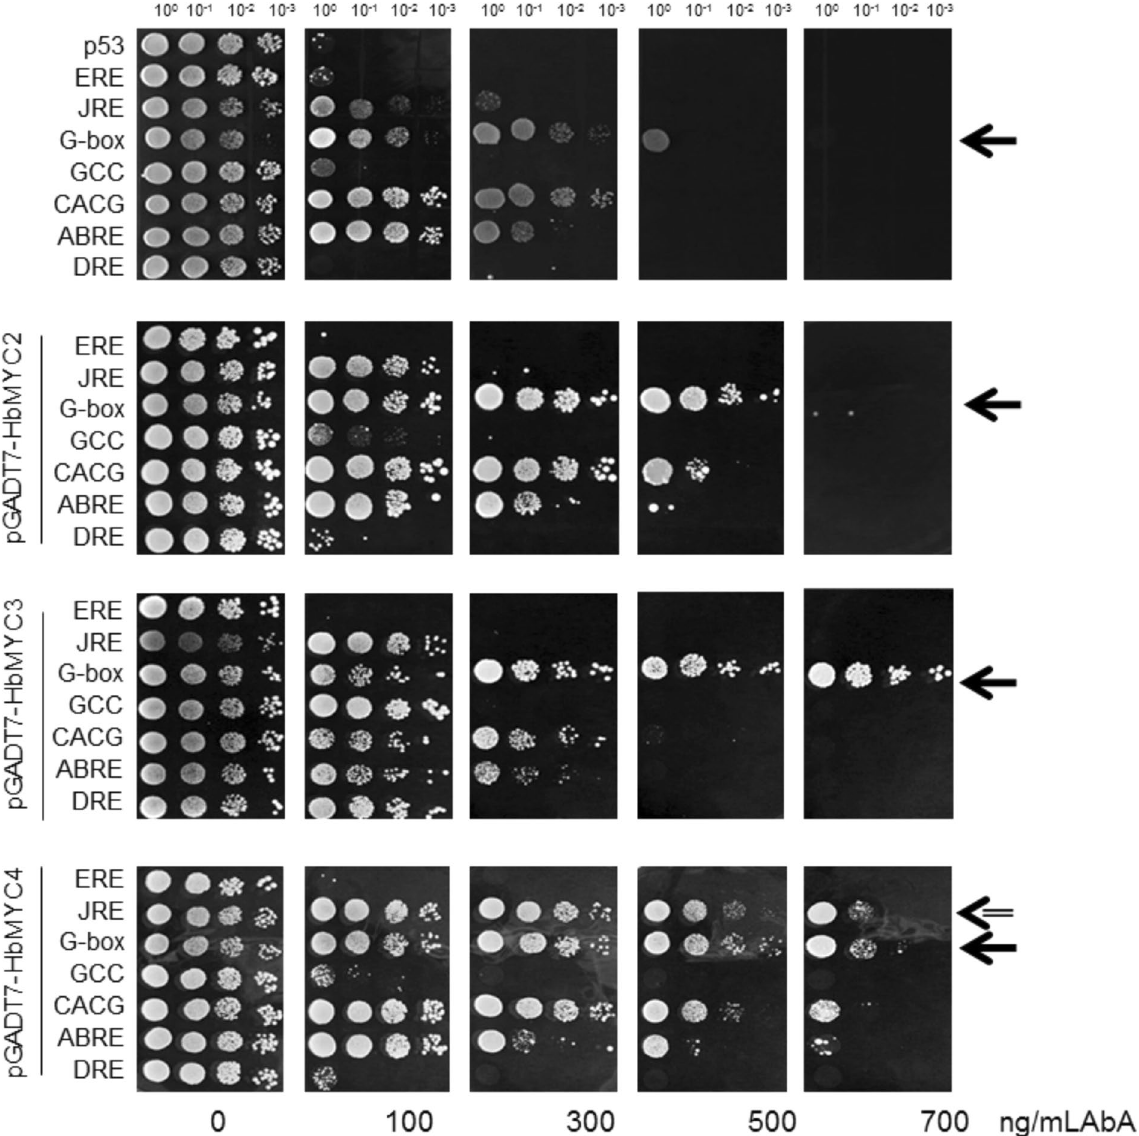
Figure 5. Interaction between HbMYCs and cis-elements by yeast one-hybrid assays. pGADT7-Rec2- HbMYC2 , pGADT7-Rec2- HbMYC3 and pGADT7-Rec2- HbMYC4 were transferred into Y1HGold strains containing different pAbAi-cis-element bait vectors. The strains were then plated on SD/-Leu/AbA solid media containing 0–700 ng/mL AbA to cultivate for four days at 30 °C, after which the growth of the cells was observed. Arrows indicate significant differences in the pAbAi-G-box